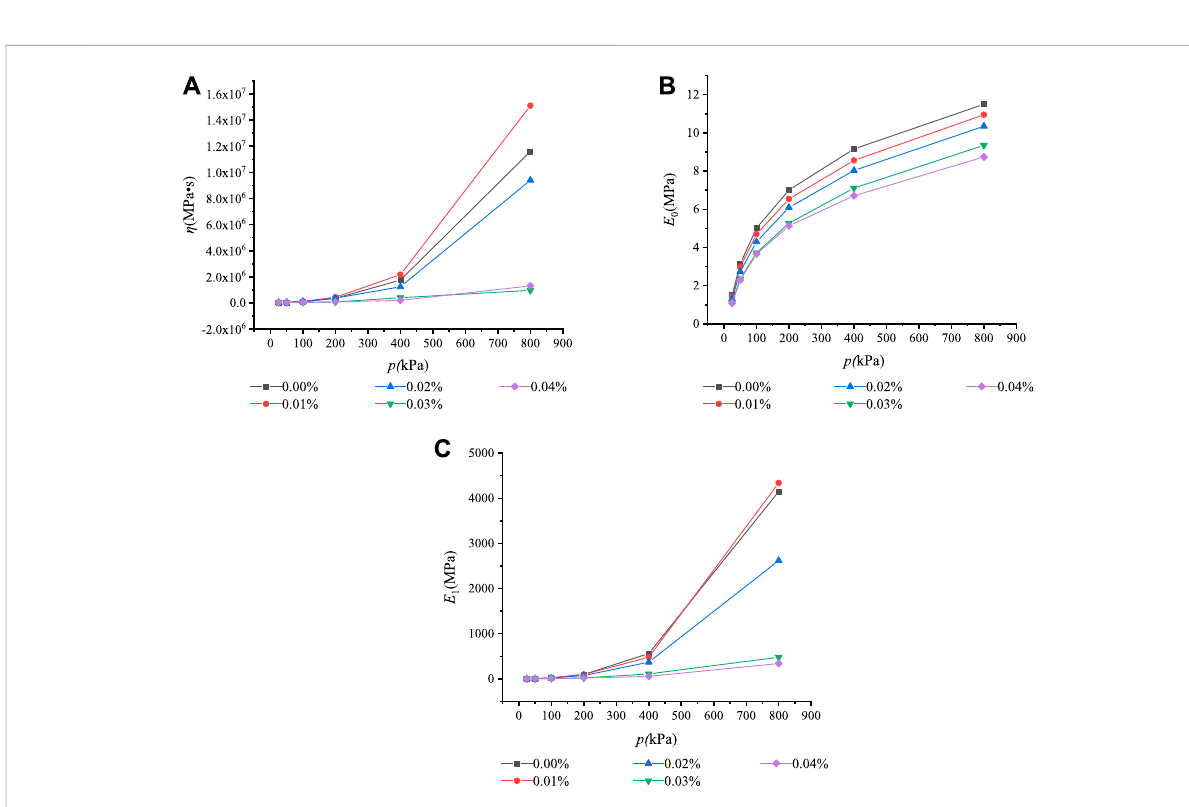
FIGURE 9 Relationship curves betweenrheological model parametersand load underdifferent ratios ofbio-enzyme: (A) relationship between modulus η and load; (B) relationship between modulus E 0 and load; (C) relationship between modulus E 1 and